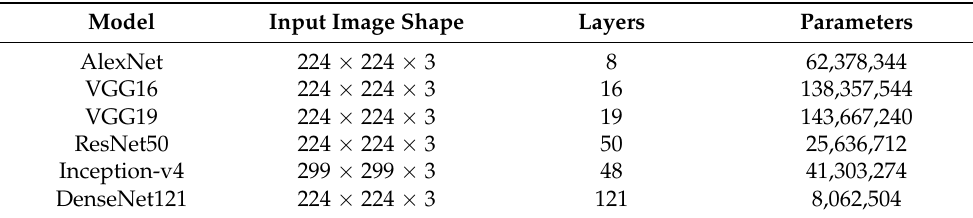
Table 1. The baseline convolutional neural network (CNN) model settings.